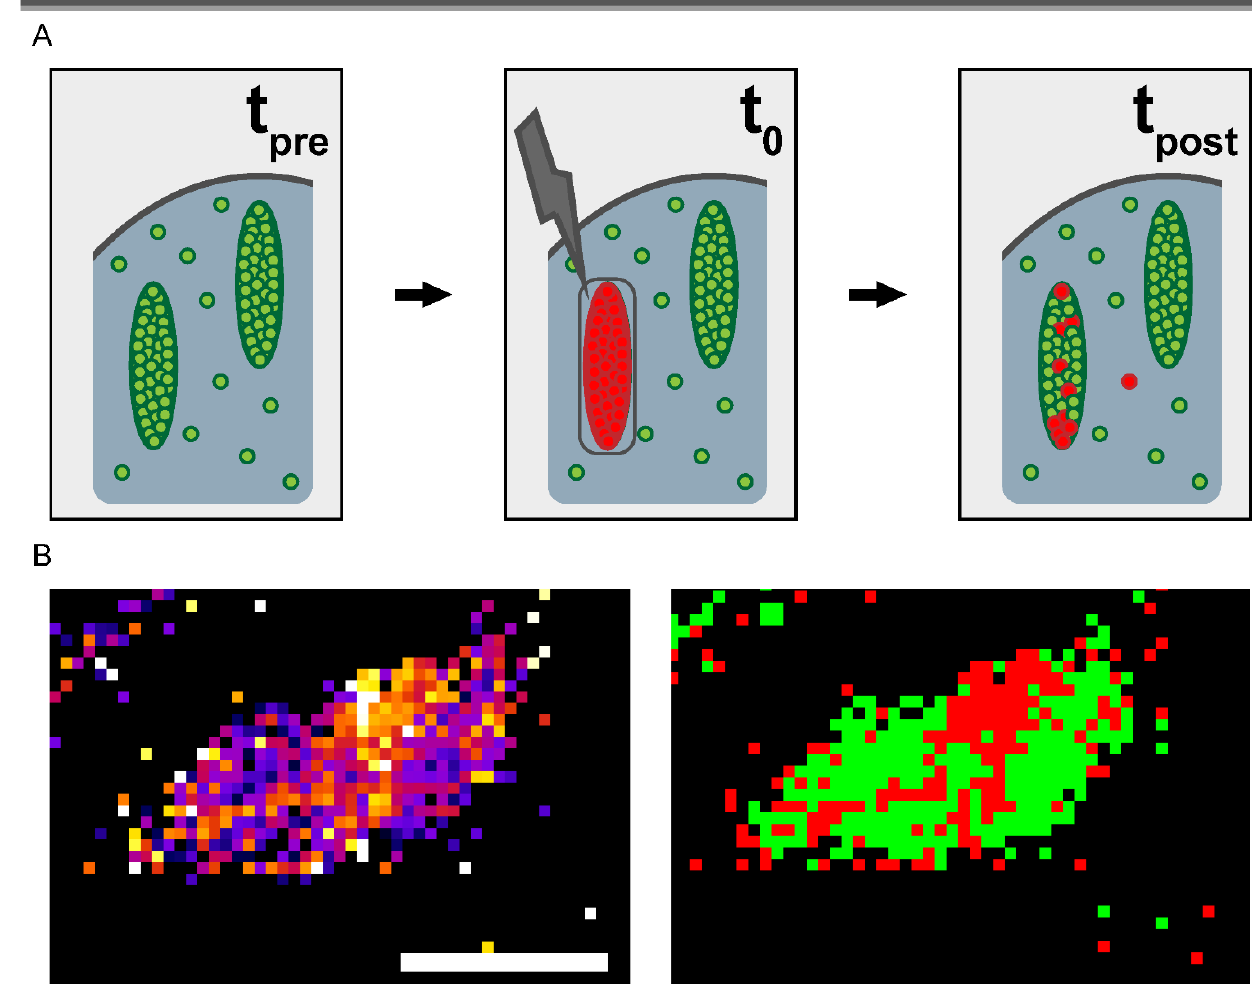
Figure 7. Photoconversion or photoactivation assay. ( A ) Schematic overview of a photoconversion or photoswitching assay to specifically visualise the proteins that are stably associated with a complex. The protein of interest tagged with a photoconvertible or photoswitchable fluorescent protein is expressed in the cell. Before photoconversion (t pre ), the entire complex (e.g., an FA) is one colour (here, green). A small region tightly enclosing the protein complex is briefly exposed to a low intensity of 405 nm laser light (t 0 ), converting the fluorescent proteins in this area to a different colour (here, red). After sufficient time has passed for the dynamic fraction to exchange, another image is taken (t post ). As the volume exposed to the 405 nm laser is small, most fluorescent proteins remain unconverted (green); therefore, exchanging proteins from the converted complex will almost certainly be replaced by unconverted fluorescent proteins. In this way, at t post, any remaining converted (red) fluorescence signal represents the stably bound fraction, while the unconverted signal represents the dynamically exchanging fraction. ( B ) Data from a photoconversion experiment where paxillin-mMaple3 is expressed in U2OS cells. Left image shows the ratio of converted signal at t post over the converted signal at t 0 on a pixel-by-pixel basis. Blue/purple indicates a low ratio representing the dynamically bound fraction, white/yellow a high ratio and the stably bound fraction. The right image is threshold showing the stably bound fraction in red and the dynamically bound fraction in green. Scalebar: 1 µm. Adapted from Legerstee et al. 2019 [58] .